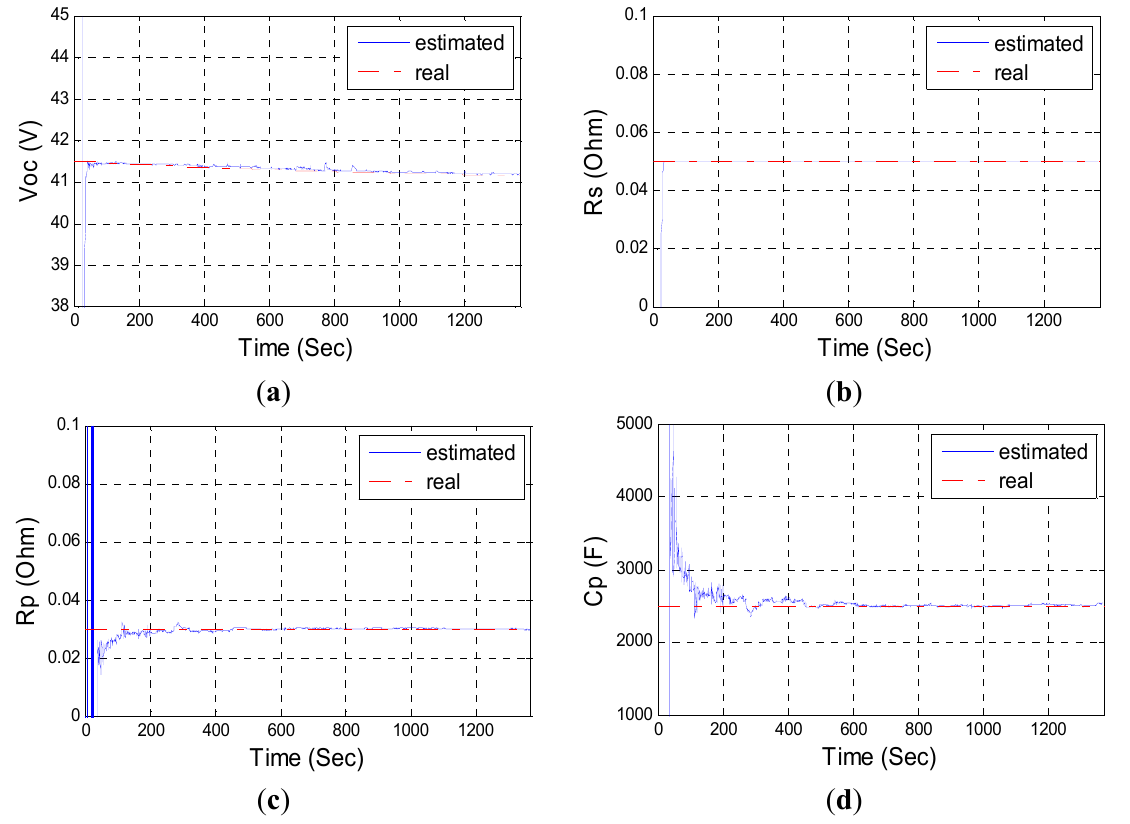
Figure 3. Real and estimated results of the simulation: ( a ) OCV; ( b ) s R ; ( c